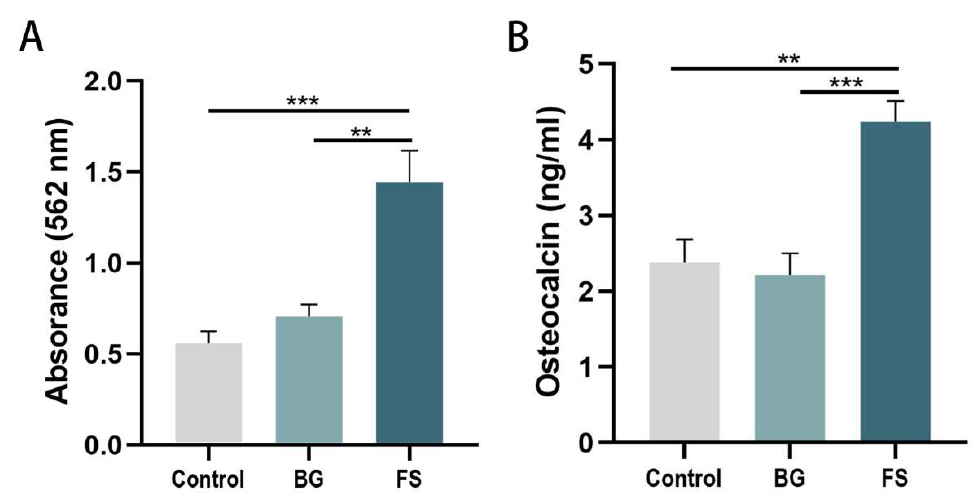
Figure 8. Relative quantitative assay of mineralized deposits ( A ) and ELISA analysis ( B ) of glass slide control, BG and FS group (** p < 0.01, *** p < 0.001).